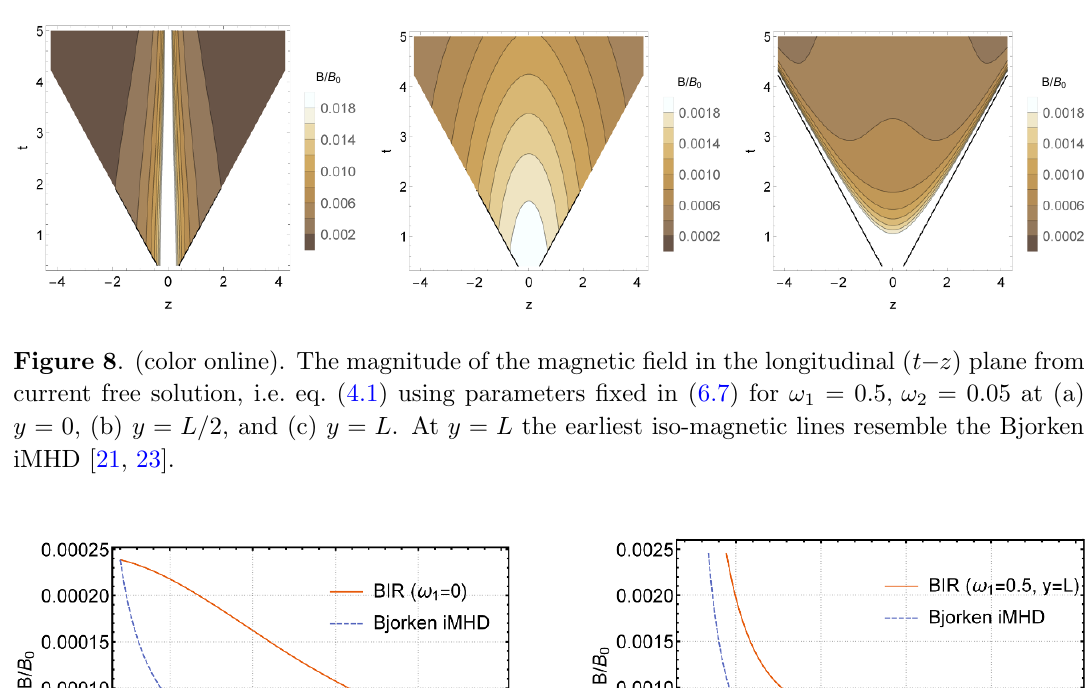
n o x = y = x ? ; (cid:17) = 0 ; ! 1 = 0 : 5 . 0